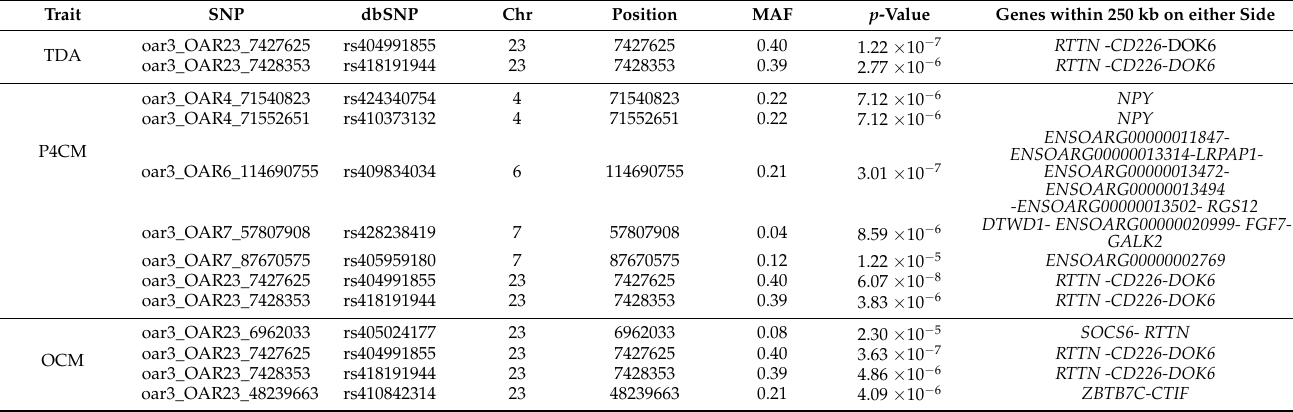
Table 2. Significant SNPs at the chromosome-wise level associated with each seasonality trait. The SNPs are ordered according to their positions in the Oar 3.1 genome version (Ensembl release 81). Minor allele frequency (MAF) is also indicated. Putative causal genes located in the 250 kb region on both sides of the significant SNPs are indicated. Trait